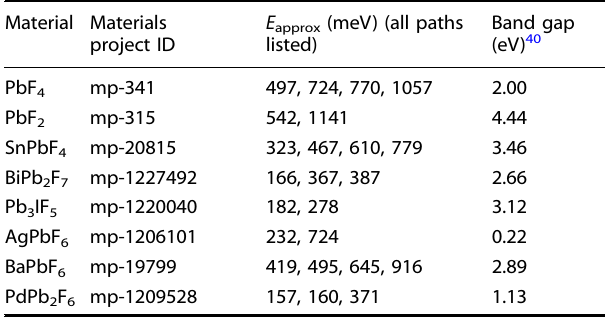
Table 1. Subset of promising Pb-containing phases.